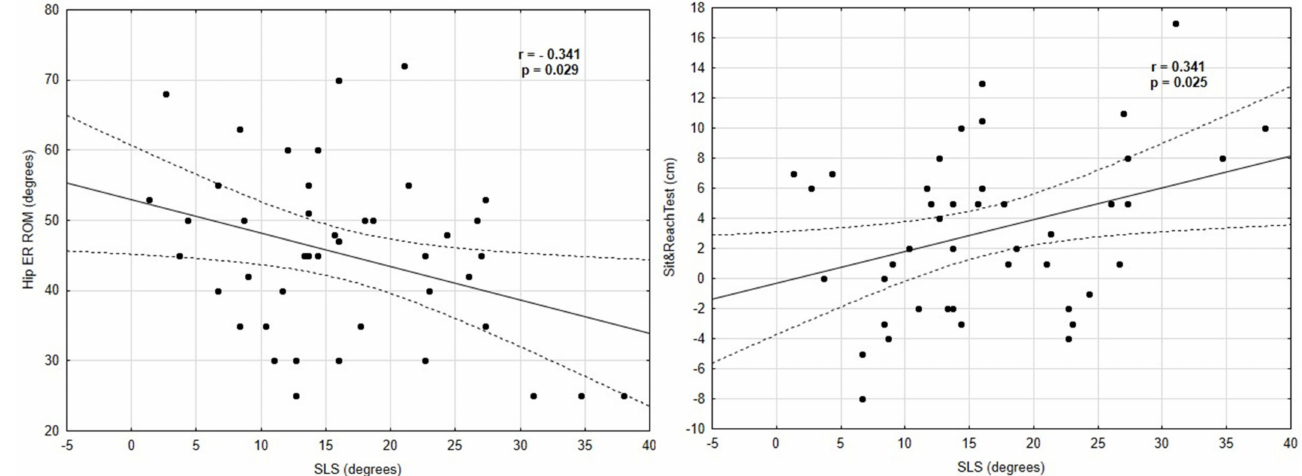
Figure 2. Correlations between the SLS and the hip ER ROM and sit and reach test results.